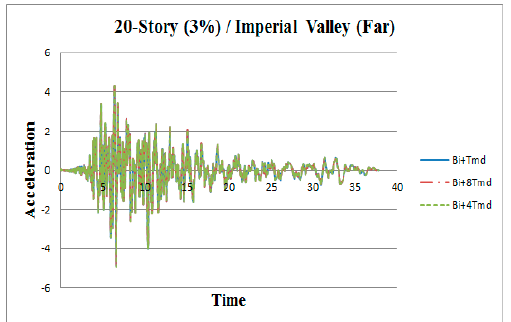
Figure A7. Acceleration time histories for top story of 20-story building under the Imperial Valley (far-fault) earthquake.